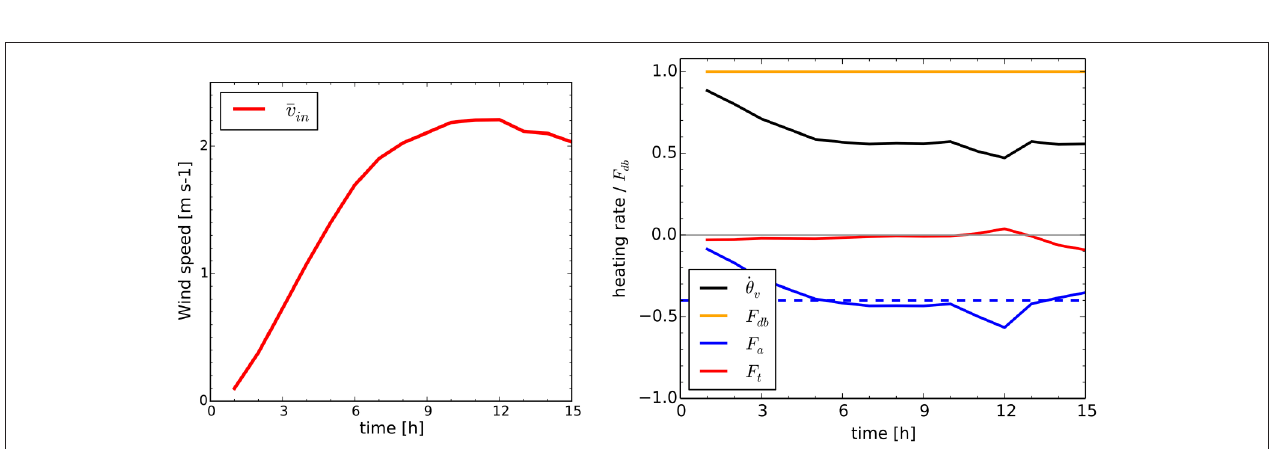
FIGURE 5 | Time evolution of the mean up-valley wind at the valley entrance (left panel) and the heat budget tendencies for the valley control volume (right panel). ¯ υ in denotes the average of the along-valley wind over the inflow layer, that is up to h e . The dashed line indicates the a-priori estimate, f a ( h c ) , of the steady-state advective heating rate.